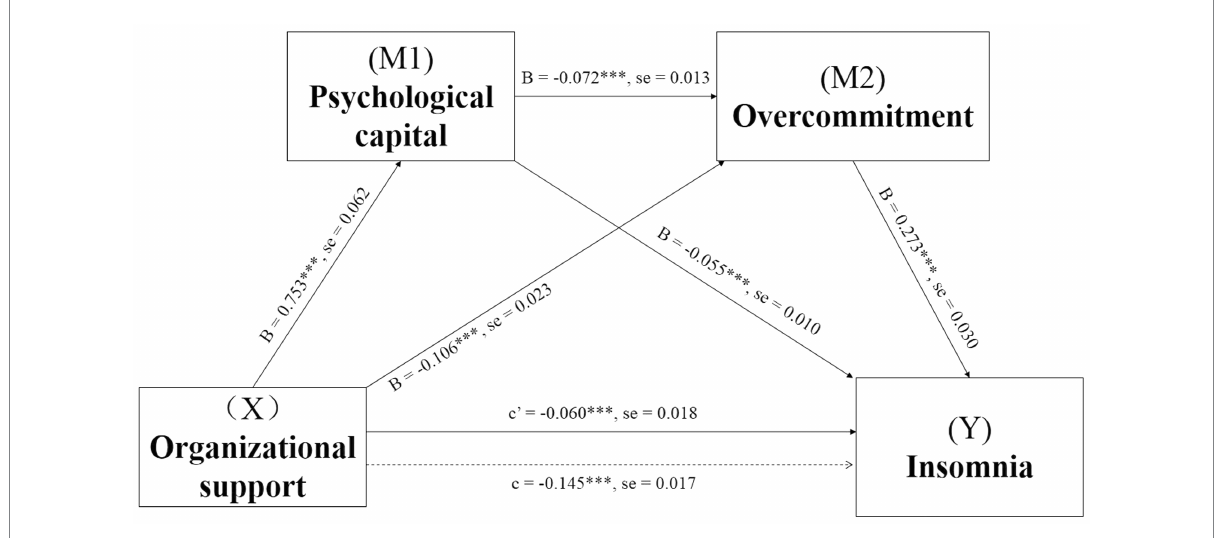
FIGURE 2 Serial-multiple Mediating effects of psychological capital and overcommitment between perceived organizational support and insomnia with non-standardized beta values and standard error. *** p <